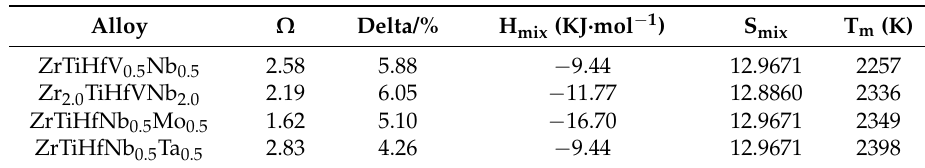
Figure 1. X-ray diffraction patterns of the refractory high-entropy alloys (RHEAs).